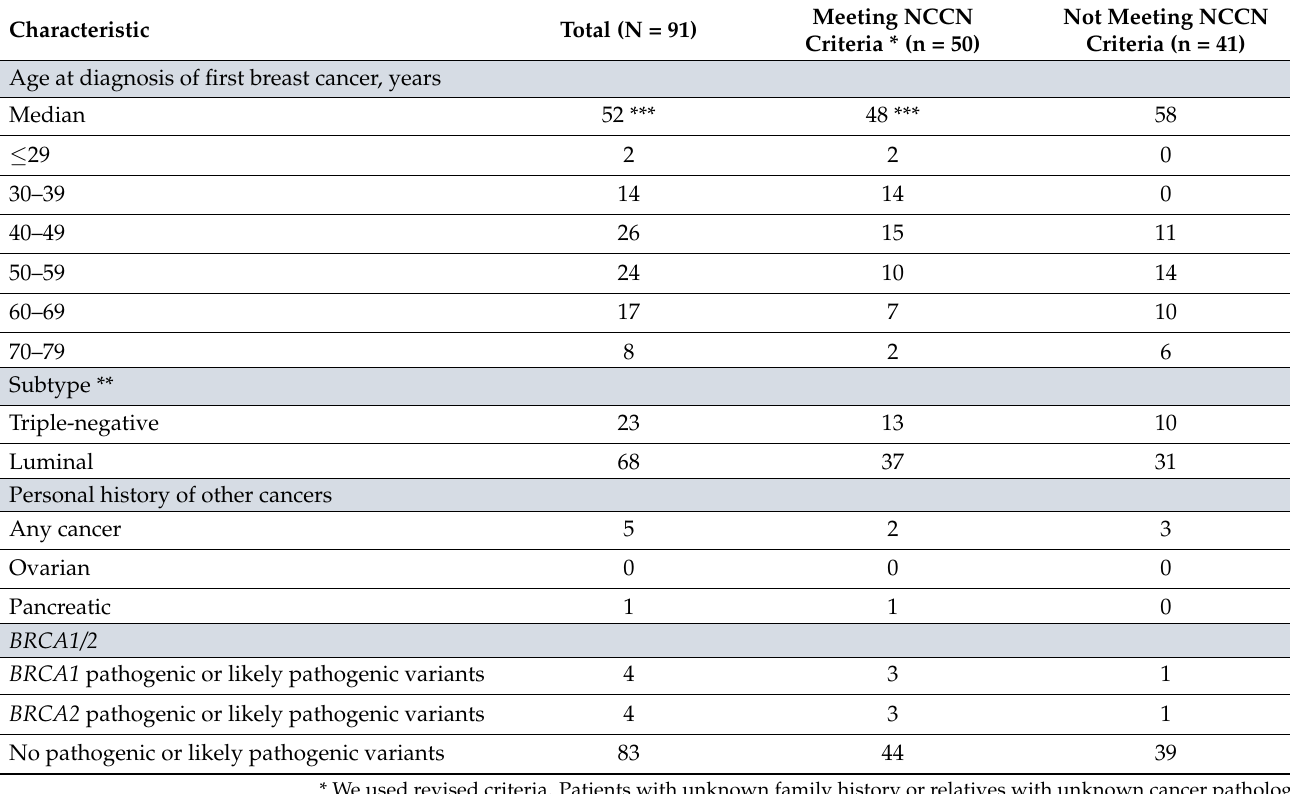
Table 1. Characteristic of the patients.